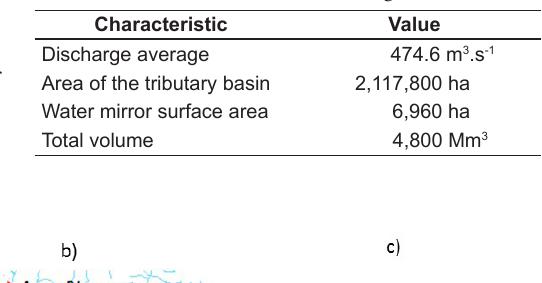
Table 1. Discharge average (Discharge), Area of the tributary basin (Area), Water mirror surface area (Surface), Total Volume (Volume) of the Hidrosogamoso